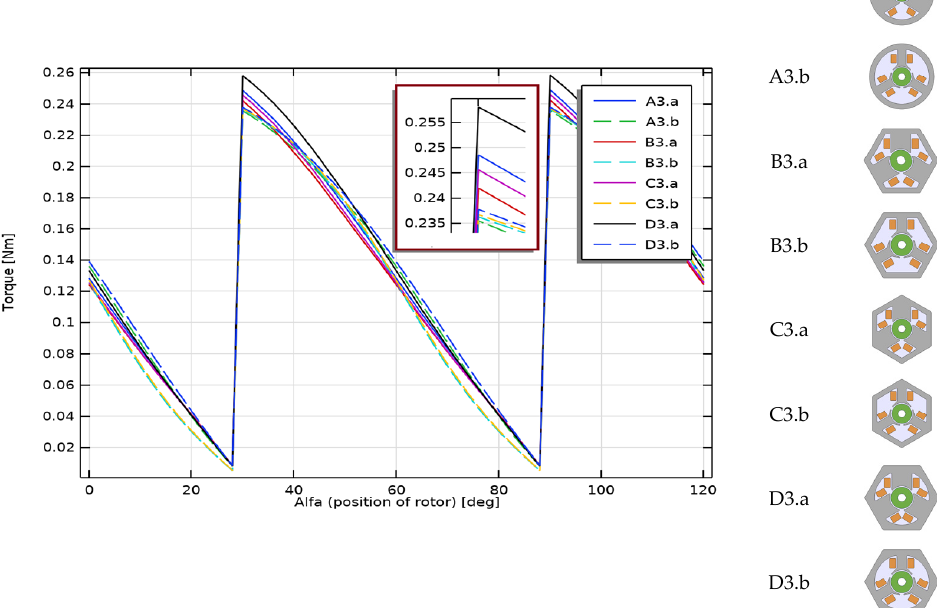
Figure 15. Axial torque for the rotor position from 0 ◦ to 120 ◦ . A band switching point was adopted for the rotor position, for which the torque is